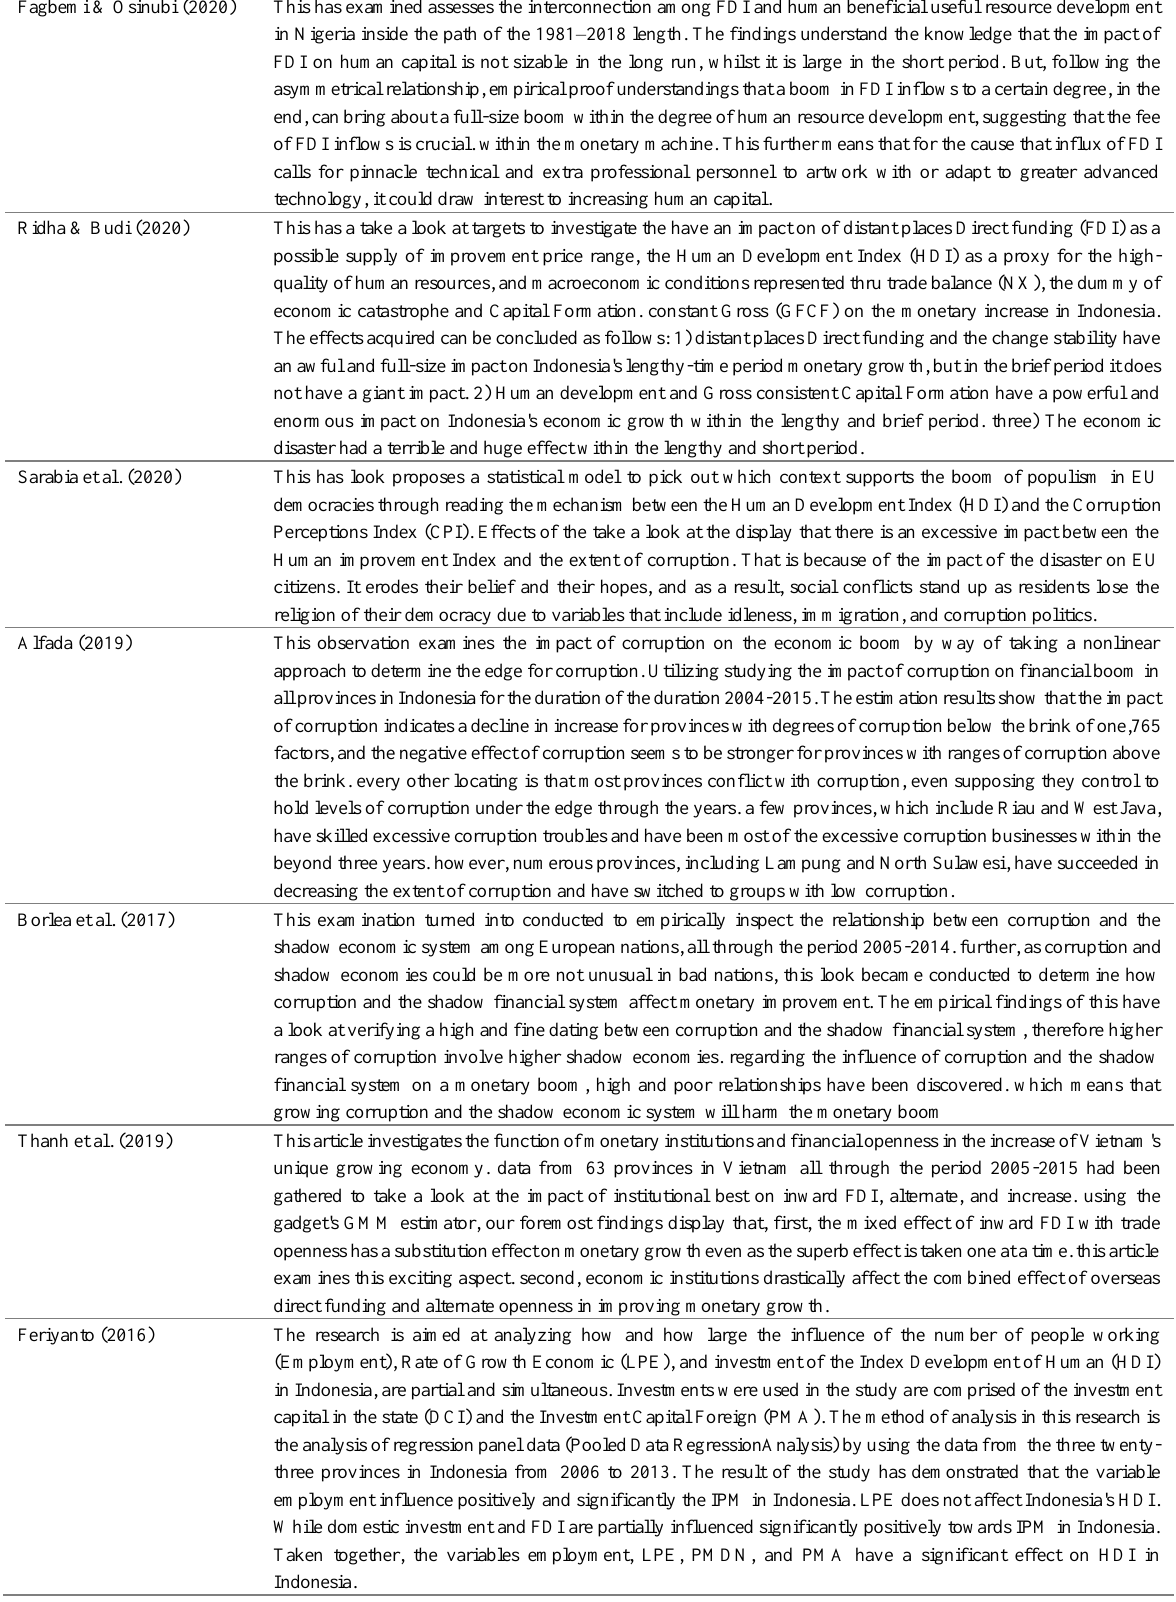
Table 1: A summary table for selected empirical